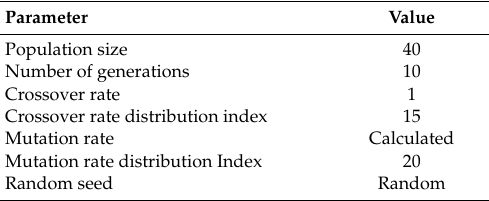
Table 3. Genetic algorithm